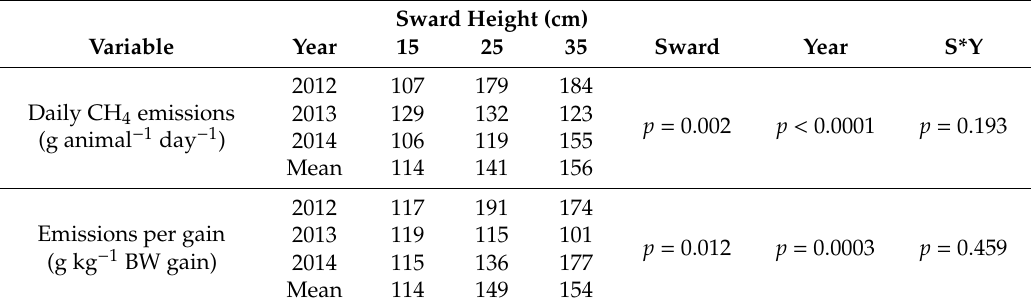
Table 6. Enteric CH 4 emissions from Nellore bulls fed on Marandu grass managed at different sward heights 1 . Sward Height (cm)